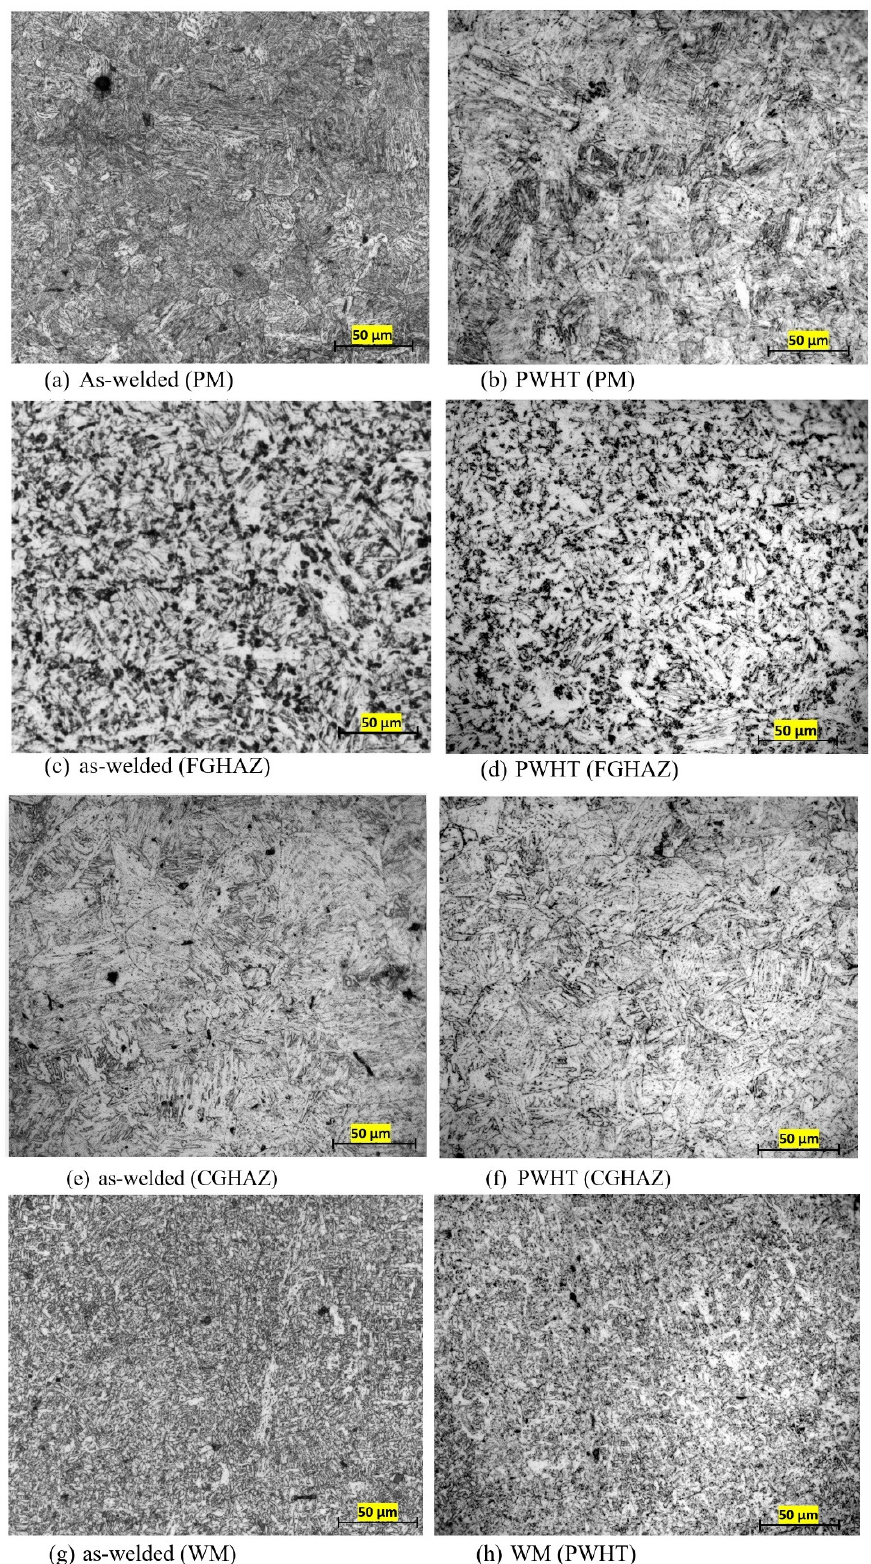
Figure 5. Optical micrographs showing the PM, FGHAZ, CGHAZ and WM in the as-welded ( a , c , e , g ) and after PWHT ( b , d , f , h ) specimens.